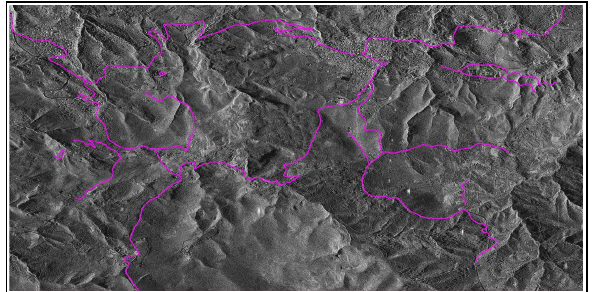
Figure 2. The 2D road network (FFLFs) on the TerraSAR-X image.